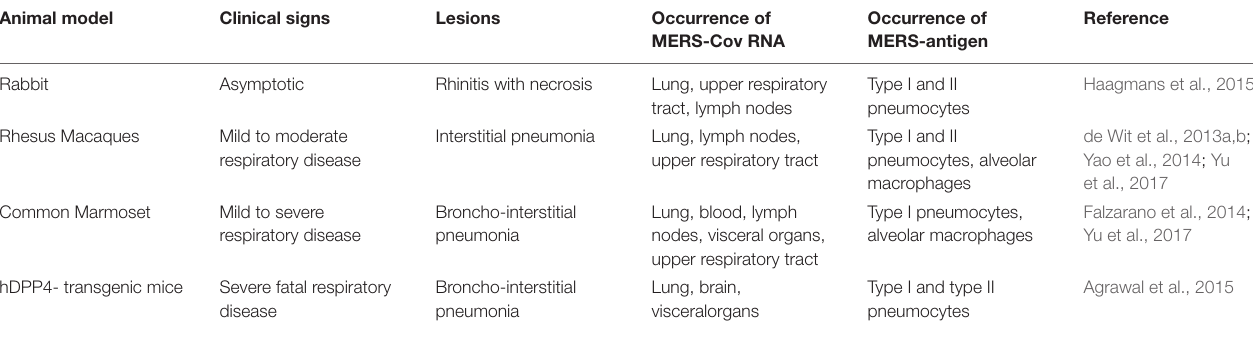
TABLE 3 | Clinical signs and lesions along with the occurrence of MERS-CoV RNA and antigens as seen in MERS-CoV infected animal models. Animal